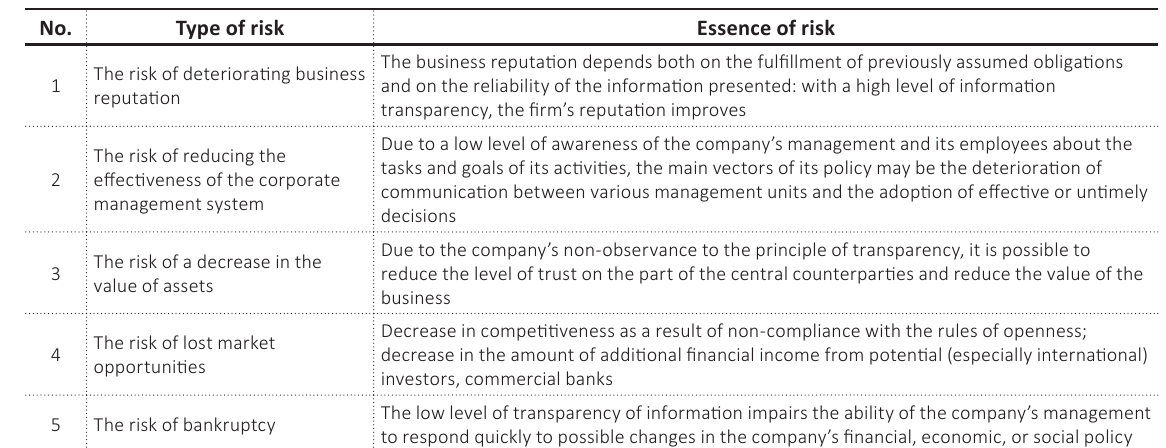
Table 1. Risks related to